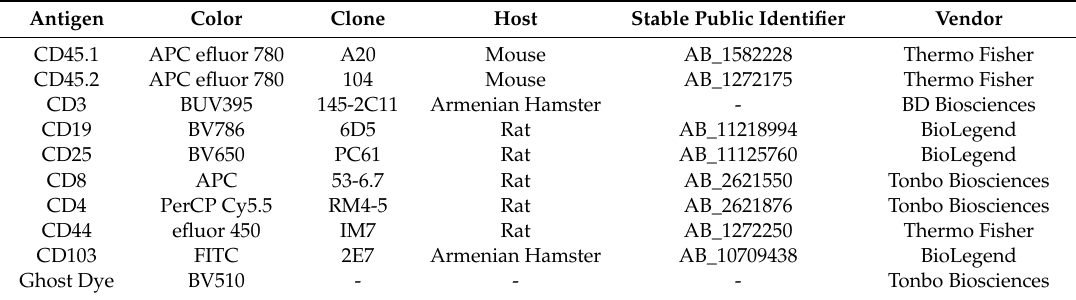
Table 2. Fluorochrome conjugated monoclonal antibody panel for flow cytometry of hapten treated flank skin samples used to identify distinct cell